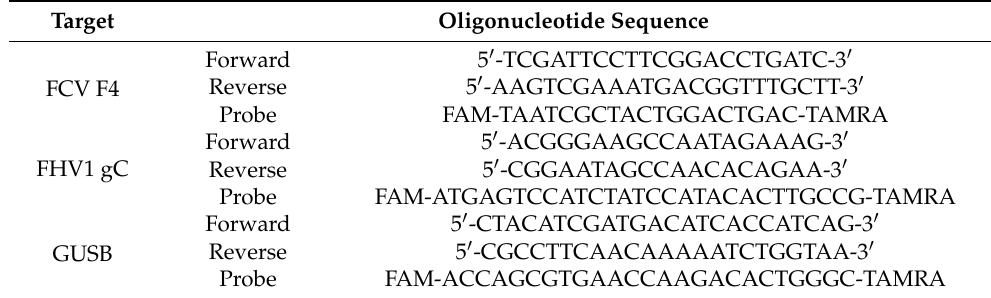
Table 1. Primer and probe sequences for real-time